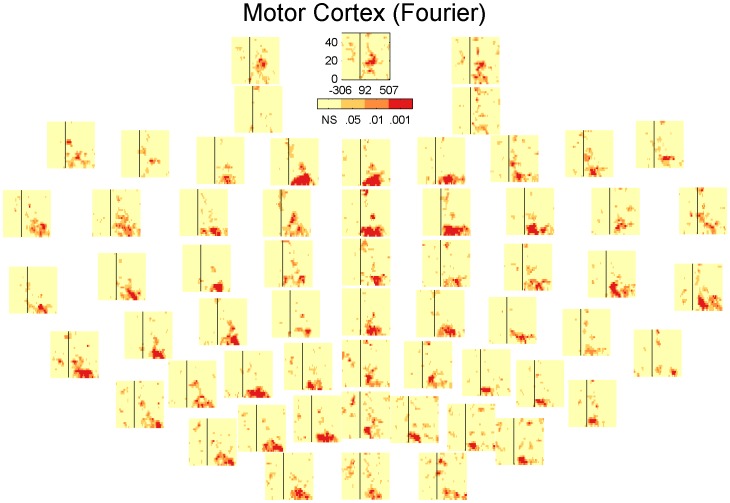
Statistical significance of each sample in the TF-maps of LICIDFT for MC corresponding to each specific electrode.